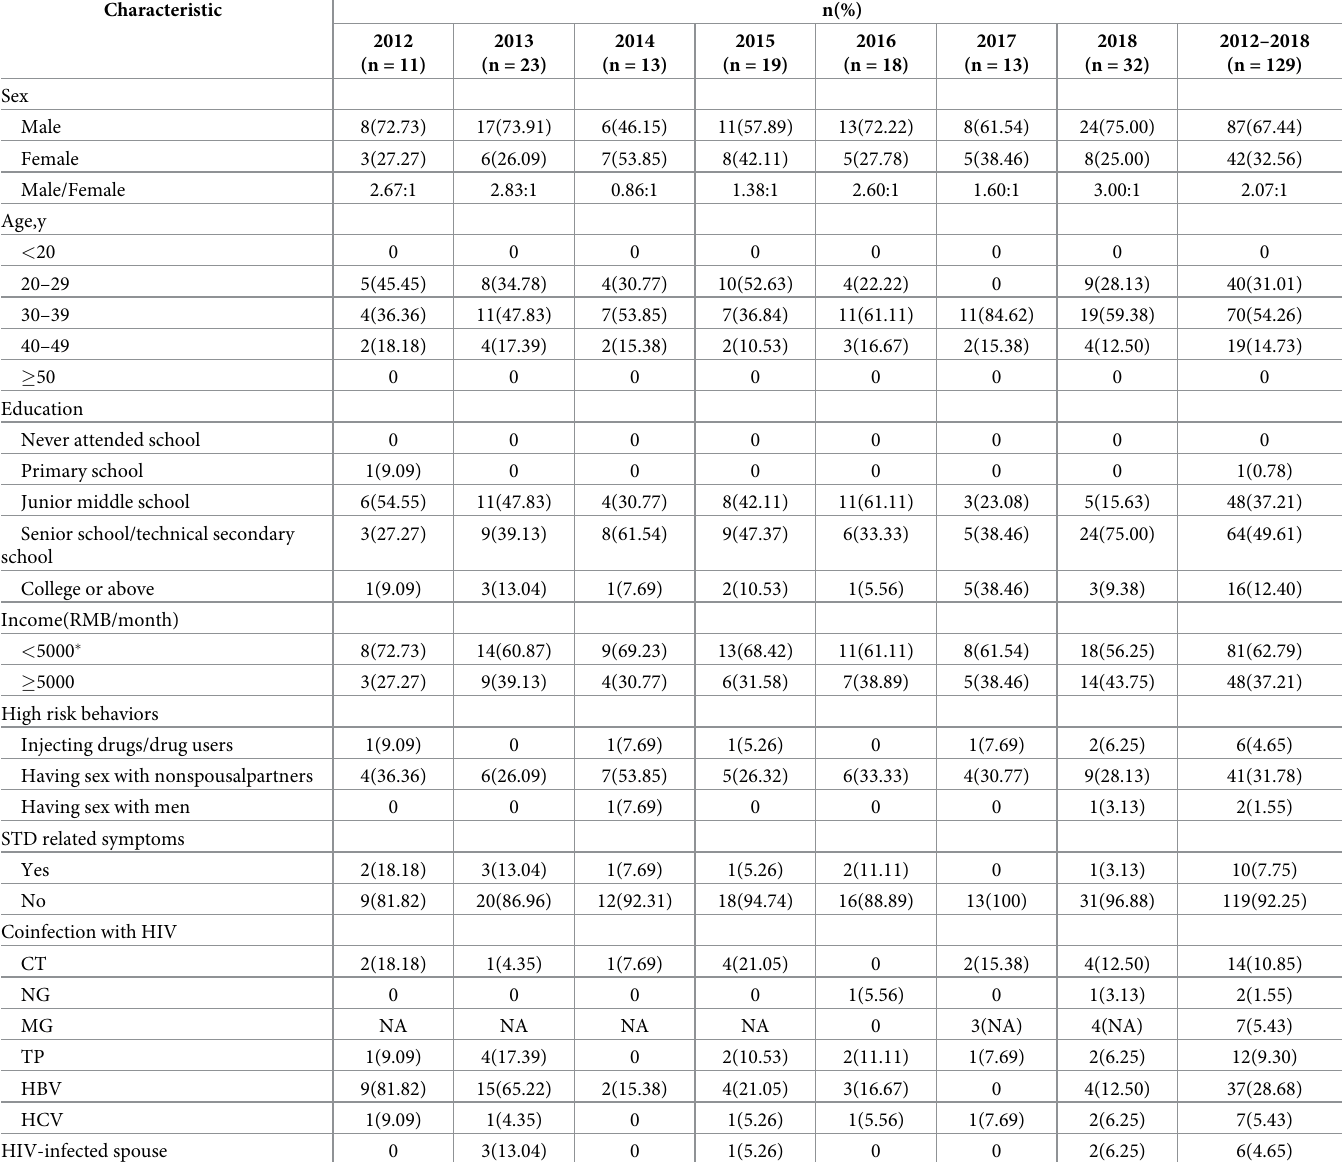
Table 3. Sociodemographic, relationship, and sexual history characteristics of HIV-infected populations in infertile couples in China from 2012–2018.